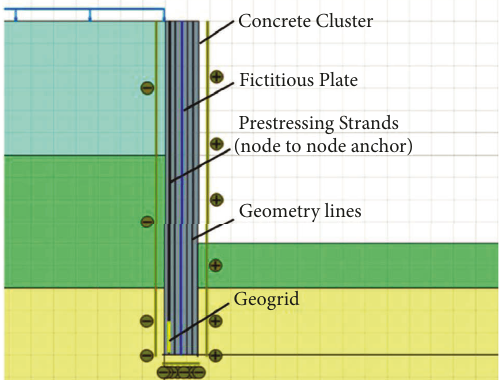
Figure 11: Modeling of prestressed concrete piles in PLAXIS 2D.